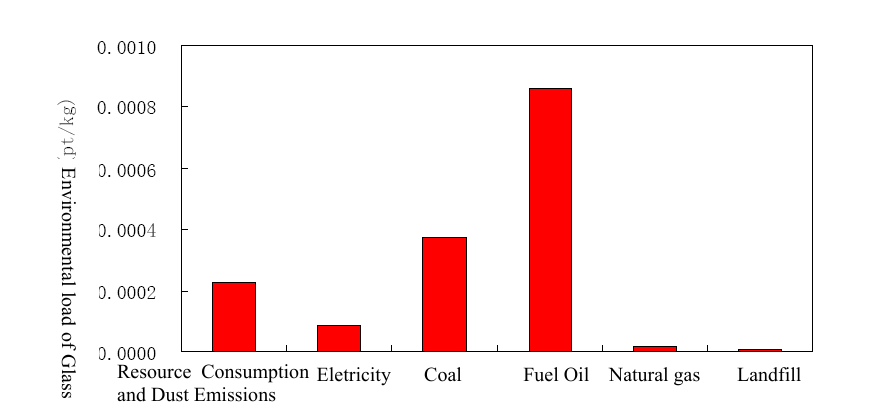
Figure 6: Environmental load of Glass